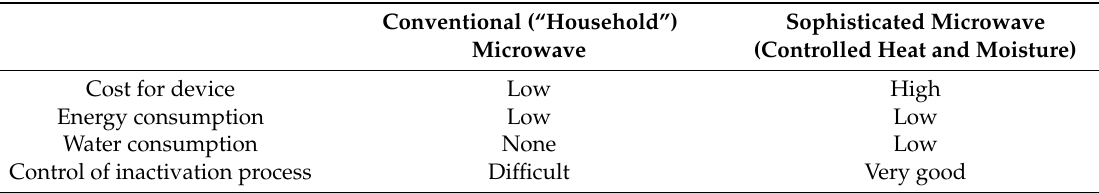
Table 1. Advantages/disadvantages of conventional and sophisticated microwave